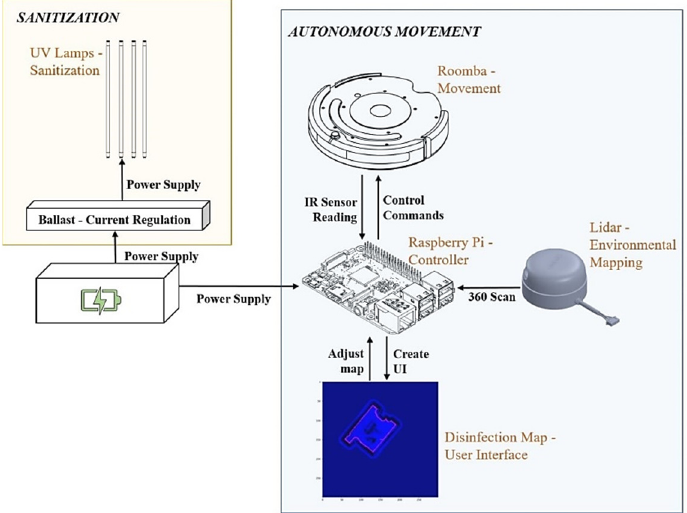
Figure 3. UVBot electrical design overview. In orange is the sanitization module containing the UV lamps and the ballast. In blue is the autonomous movement module containing the mobile robot, the LiDAR sensor, and the microcontroller. Both modules are powered by the same power supply.